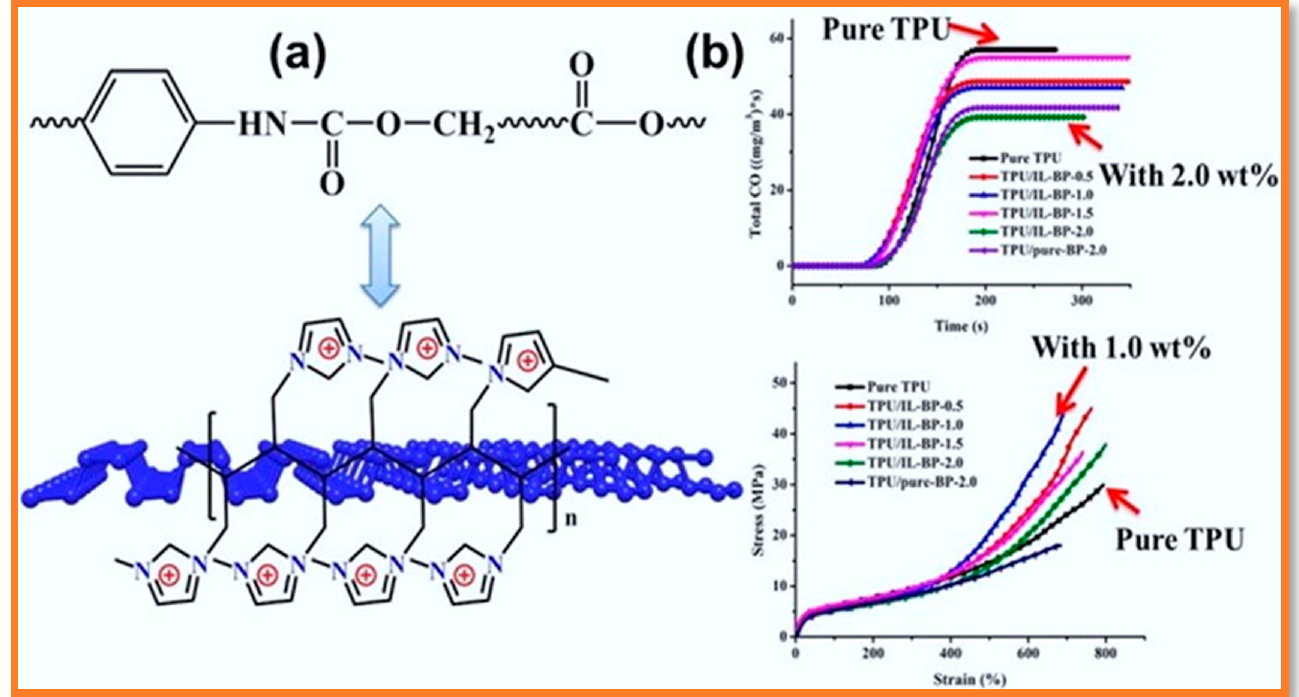
Figure 5. ( a ) A schematic illustration of (ionic liquid) IL-functionalized BP nanosheets with polyurethane (PU) matrix for flame retardants. ( b ) Different ration of TPU and IL are introduced and tested for stress and total production of CO during combustion. Copyright 2019, Elsevier Inc. Re-